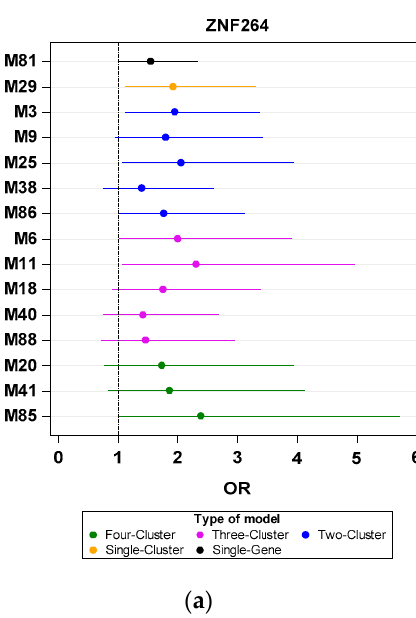
Table 5. Logistic analysis for gene–gene interactions. Percent of significance (PS) of each gene for each two-gene or three-gene model is listed.